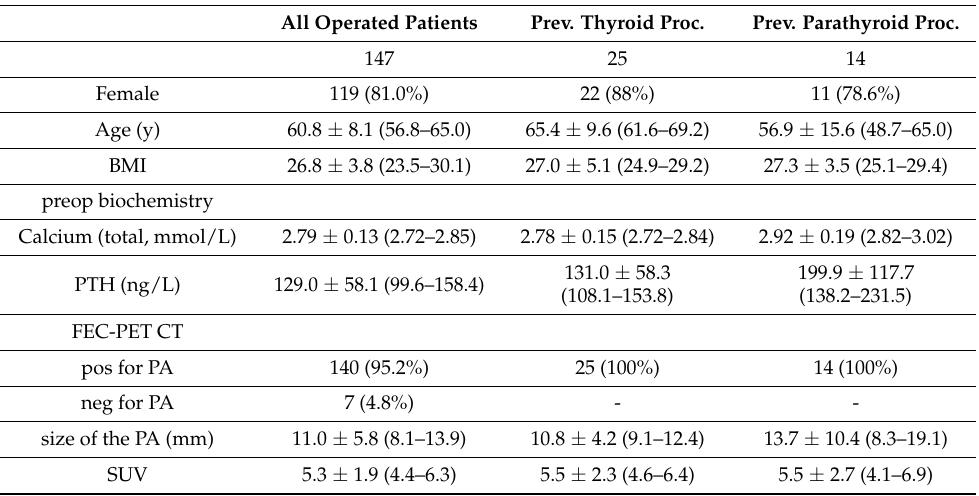
Table 3. Patients’ characteristics, intraoperative agreement (of preoperative FEC-PET-CT localized parathyroid adenomas) and postoperative results of patients operated after imaging with FEC-PET- CT. Data are presented from the entire cohort of 147 patients and the subgroups with previous thyroid and parathyroid surgery. Qualitative data are expressed as numbers; continuous data as mean ± SD and 95% confidence interval. * One patient with previous thyroid resection developed a vocal cord paresis contralateral to the current operated side and another paresis occurred ipsilateral in a patient with simultaneous hemithyroidectomy. ** One patient had synchronous thyroidectomy for Graves’ Disease, and another had a reoperation for persisting pHPT, respectively (Ref.